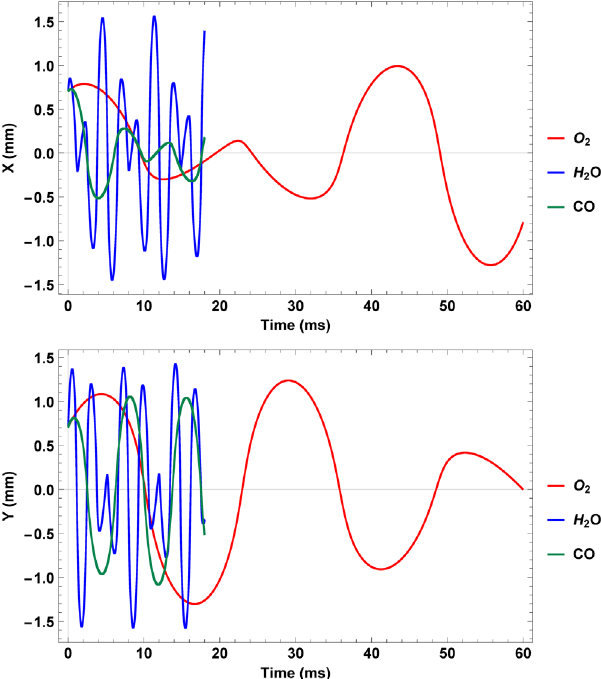
FIG. 7. Motion of neutral molecules initially at 1 mm from the beam with a thermal velocity corresponding to a temperature of 0.9 mK, and subjected to the electromagnetic field of the beam, in the horizontal (top) and the vertical direction (bottom). Different colors correspond to different molecules as indicated.